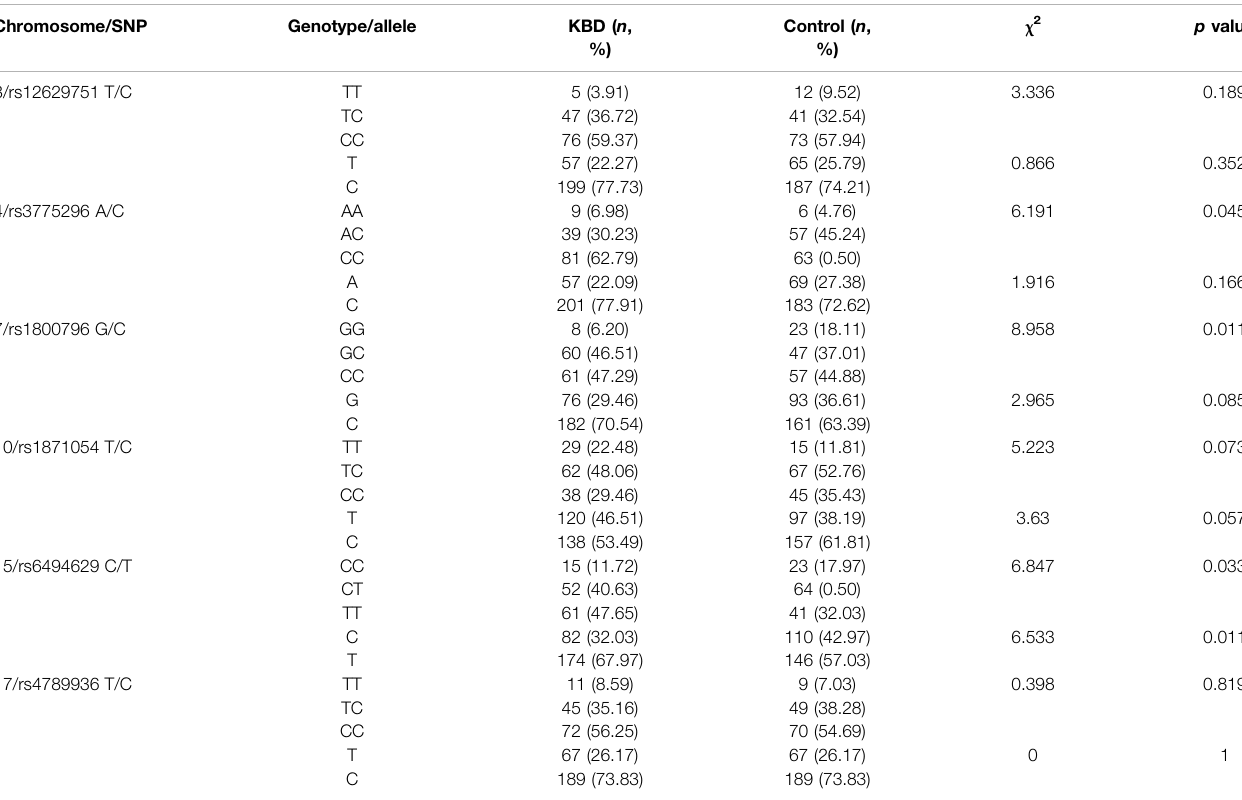
TABLE 3 | Comparison of genotypes and alleles between the KBD and control groups.